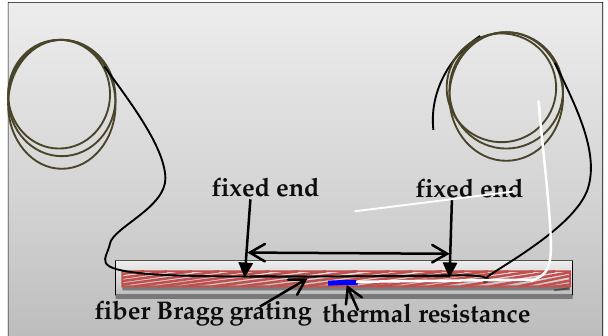
Figure 6. Installation position of FBG sensors.